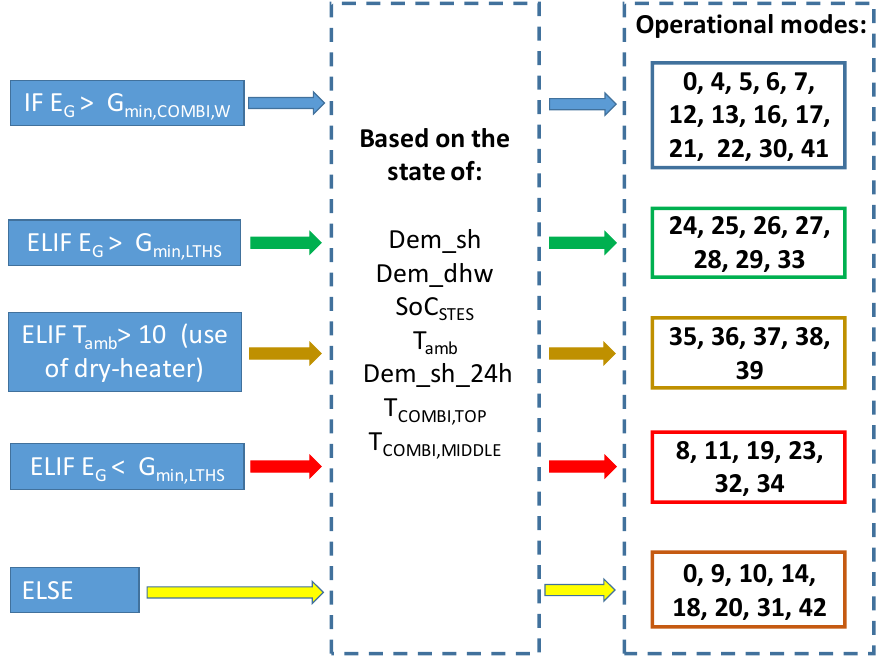
Figure A2. Simplified control policy for winter.